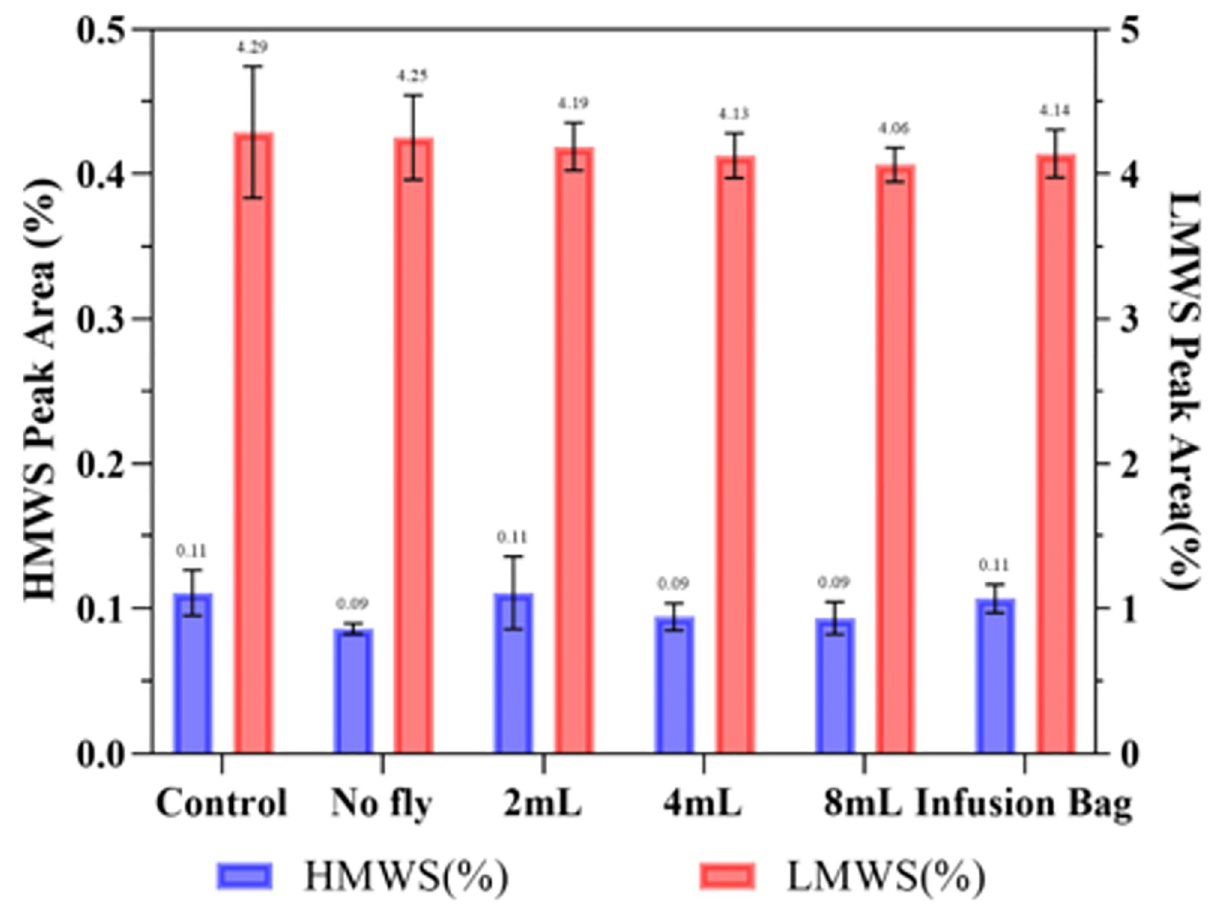
Fig 12. SE-HPLC peak area (%) of Rituximab of aggregates (HMWS) and fragments (LMWS) in different storage conditions. Data are shown as mean ± SD (n = 3). Data are shown as mean ± SD (n = 3).